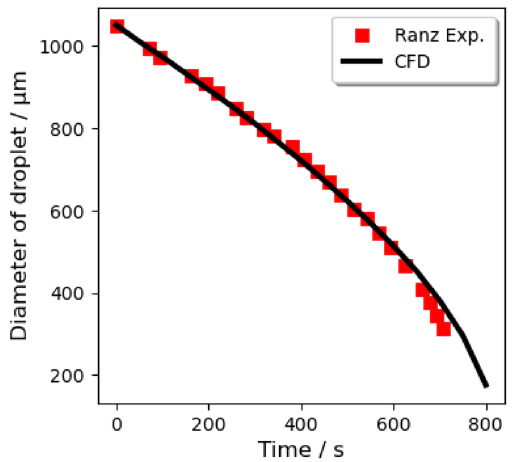
Figure 12. Experimental validation of CFD model by saliva droplets size change 56